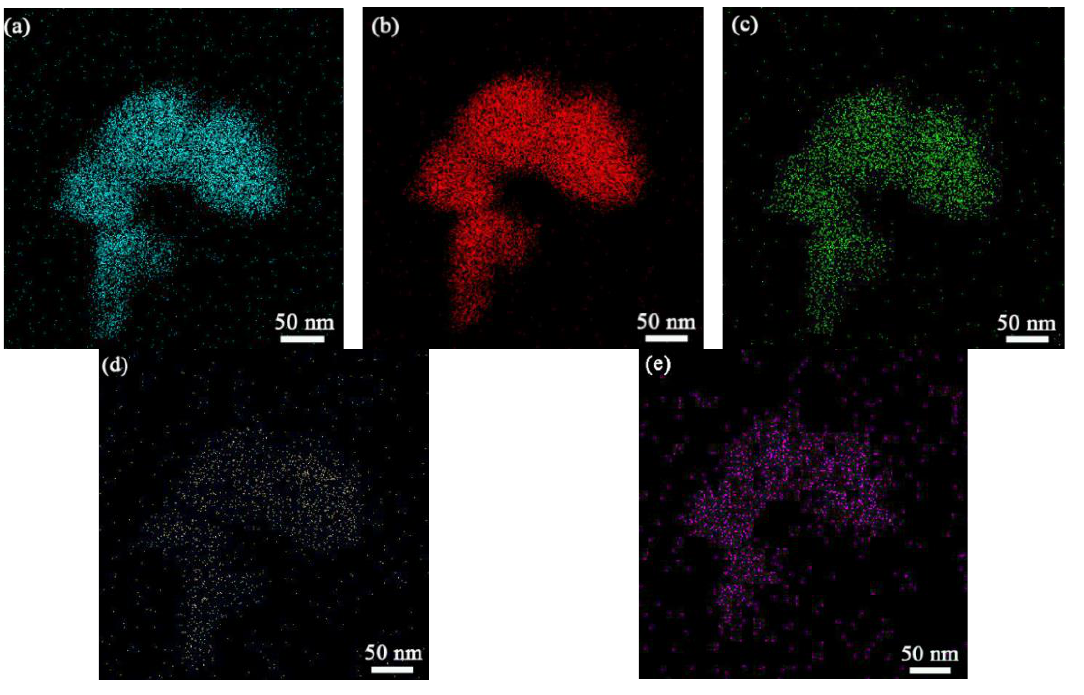
Figure 3. Element distribution of ZGMSO:Cr 3+ ( x = 0.05 sample), with ( a ) Zn, ( b ) Ga, ( c ) Mg, ( d ) Si, ( e ) Cr.